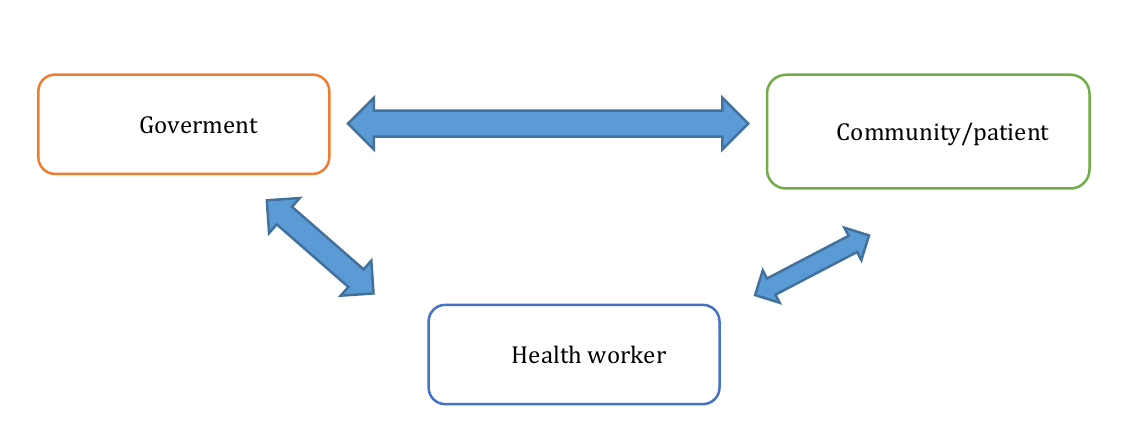
Fig. 2 Worldview understanding